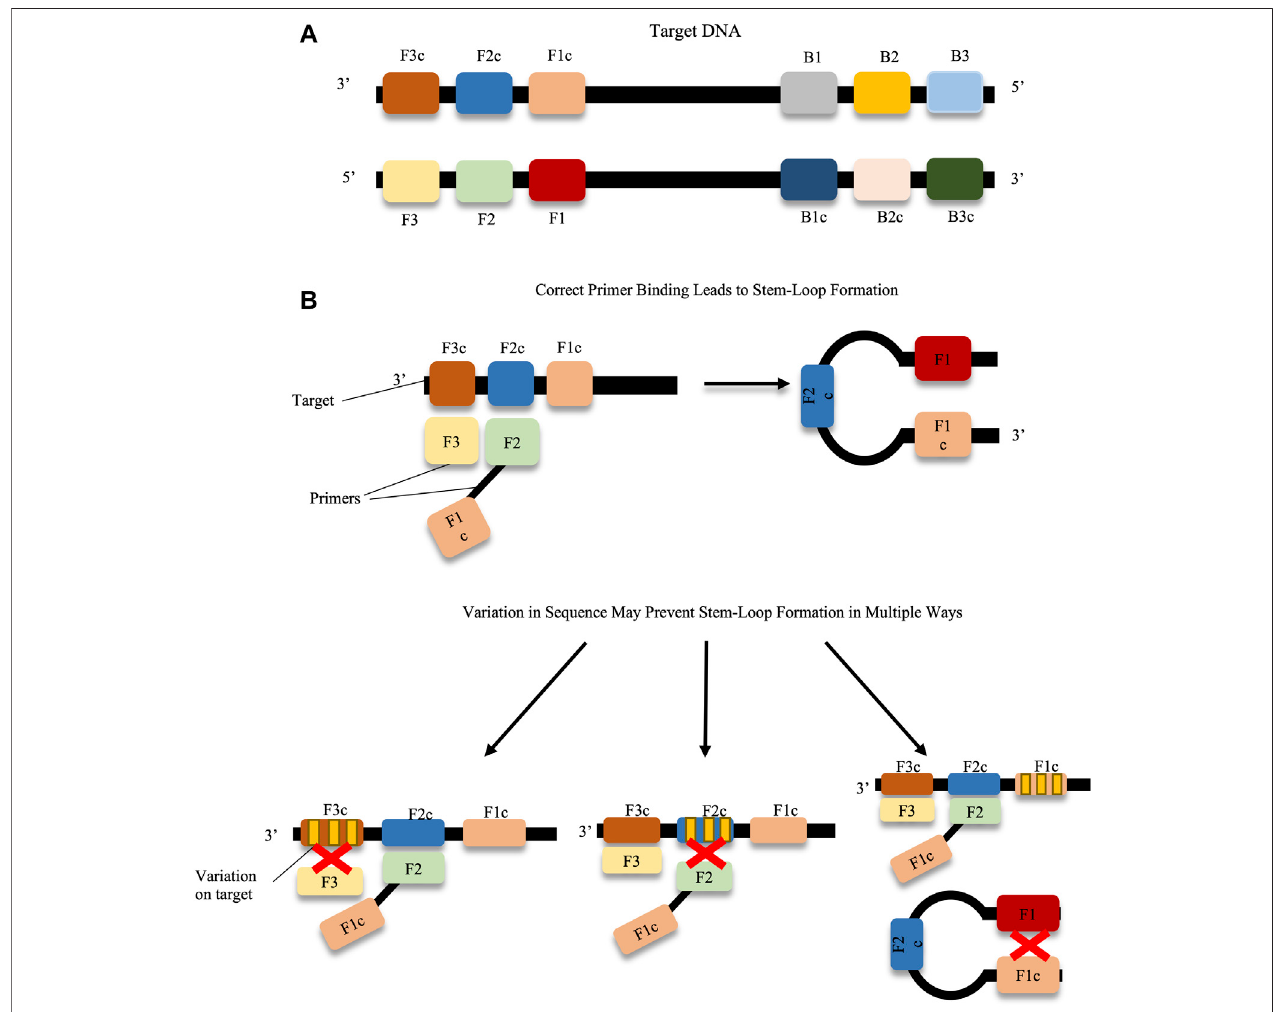
FIGURE 3 | Prevention of stem-loop formation caused by target sequence variations. (A) F1-F3, F1c-F3c, B1-B3 and B1c-B3c on the target DNA represent the binding regions for the LAMP primers, e.g. primers F3 and F2-F1c as shown in the diagram. If each of the primers matches suitably with the target DNA, stem loop formation proceeds. (B) Variation across any primer-binding sites (represented by yellow bands on target regions) can prevent stem-loop formation, and hence ampli fi cation. Primer design can be challenging when trying to avoid these variable regions.